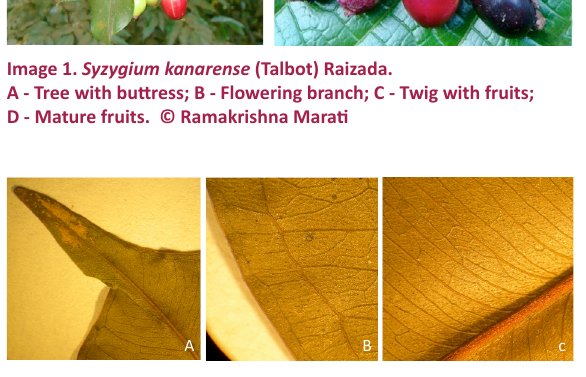
Image 2 . Syzygium kanarense (Talbot) Raizada. A - Leaf tip; B - Leaf showing intramarginal veins; C - Leaf showing glands. © Rashmi